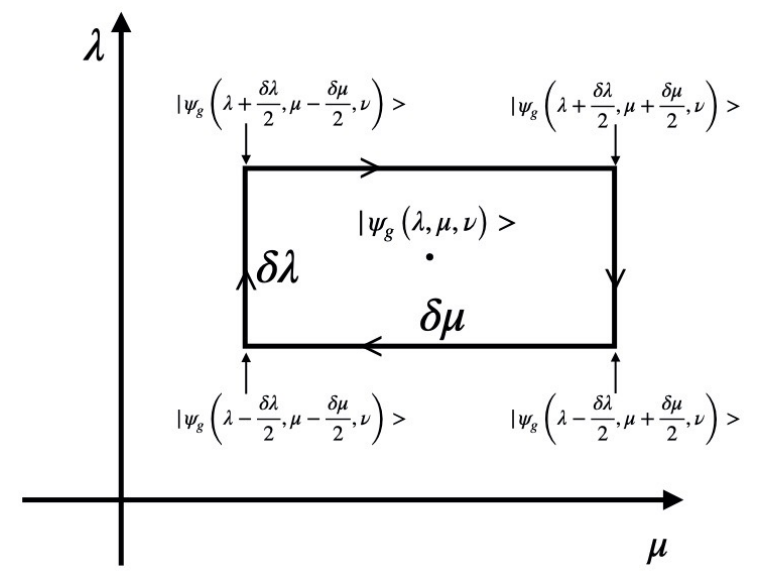
Figure 5: Rectangular circuit in the parameter